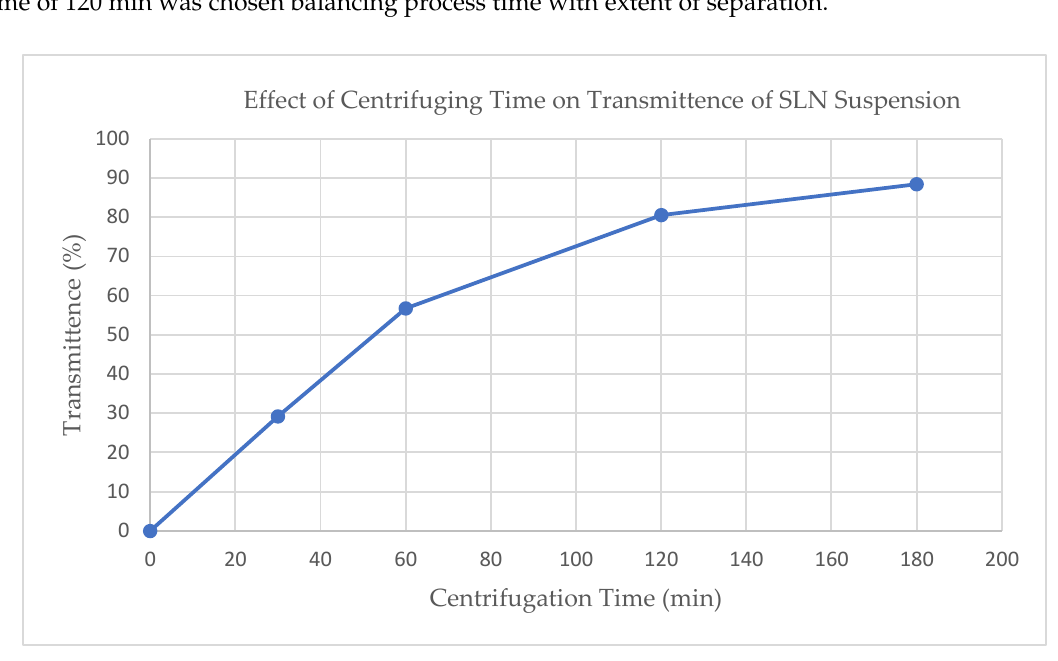
ff ect of ultracentrifugation time on SLN suspension on light scattering at 850 Figure 1. Effect of ultracentrifugation time on SLN suspension on light scattering at 850 nm. Figure 1. E